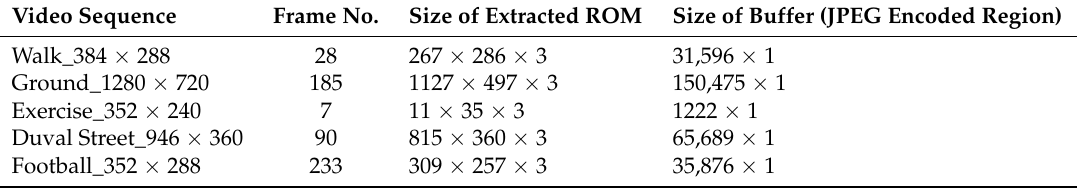
Table 1. Comparison between the sizes of the extracted Region of Motion and the consequent encoded buffer (in bytes). Video Sequence Frame